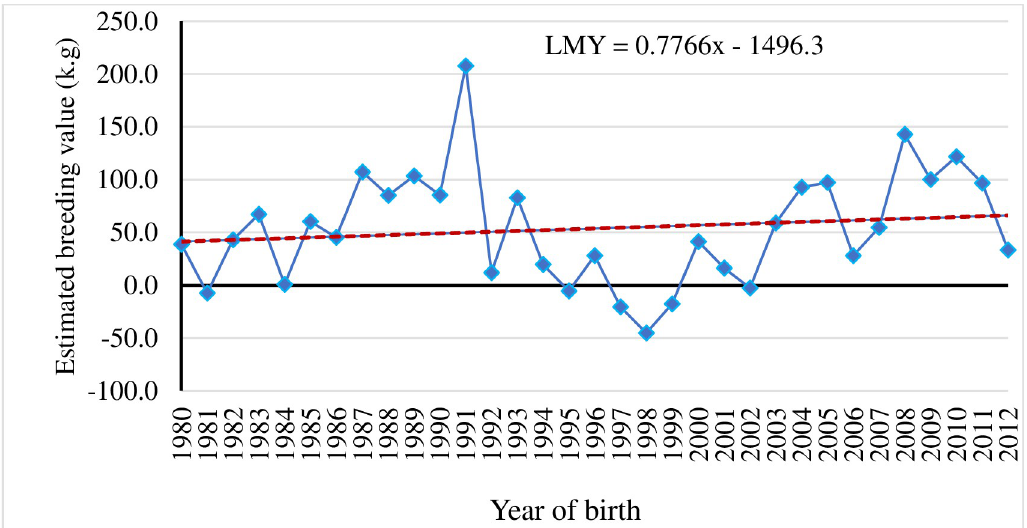
Fig 4. Genetic trend for total lactation milk yield (LMY) by year of birth of Sahiwal cows. ± 0.09, 305dSNFY: 0.13 ± 0.09 and LL: 0.24 ± 0.07) indicates the presence of sufficient genetic variation and scope for further improvement through genetic selection. Low heritability for LMY (0.16) and LL (0.07) in Sahiwal was also reported in semi-arid Kenya [25]. Similar low heritability estimates for lactation milk yield (0.14 ± 0.03), 305-days milk yield (0.13 ± 0.04) and lactation length (0.074 ± 0.028) for Frieswal cattle were also reported [26]. Heritability of 0.28 for 305 days or less milk yield, 0.21 for first lactation total milk yield and 0.26 for first lactation length were observed in Sahiwal cattle [27]. In contrast to our results, low heritability estimates of 0.059 in the first lactation, 0.083 in the second lactation and 0.052 in the third lactation for fat yield were also noticed in Holstein cows [28]. While, higher heritability estimates were reported for milk yield and fat yield of 0.29 and 0.34 for Chil- ean cattle breed and 0.30 and 0.32 for Jersey dairy cattle in Zimbabwe, respectively were